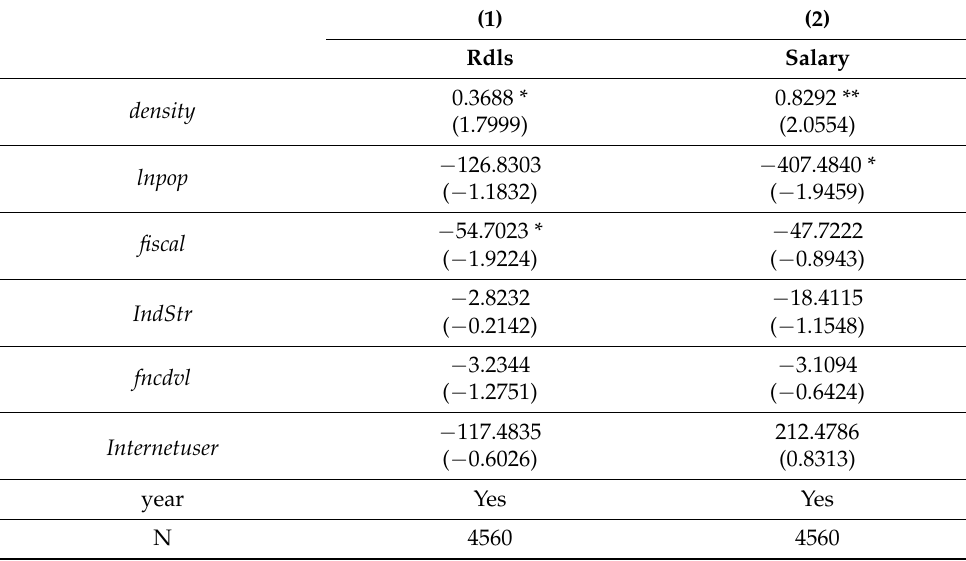
Table 4. IV estimates of the effects of density on credit